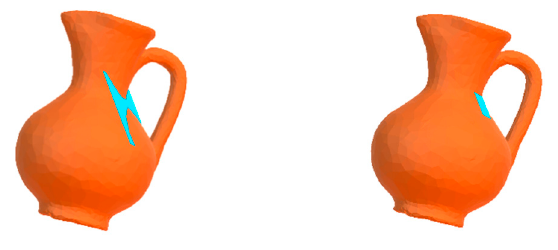
Figure 3. Adaptive modification of tactile sensor size.